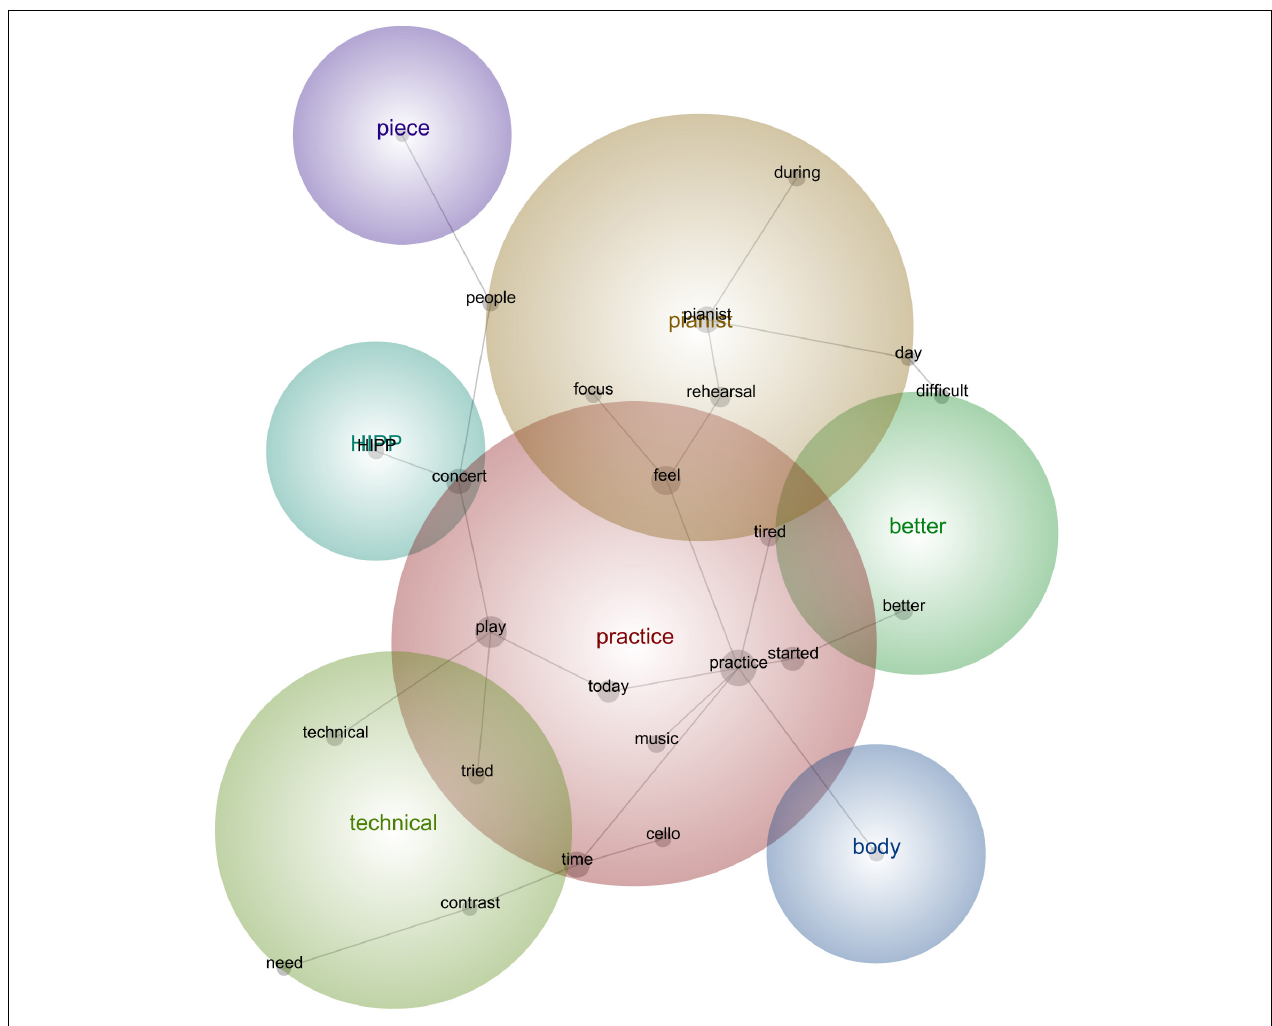
FIGURE 5 | Leximancer concept map for Concert